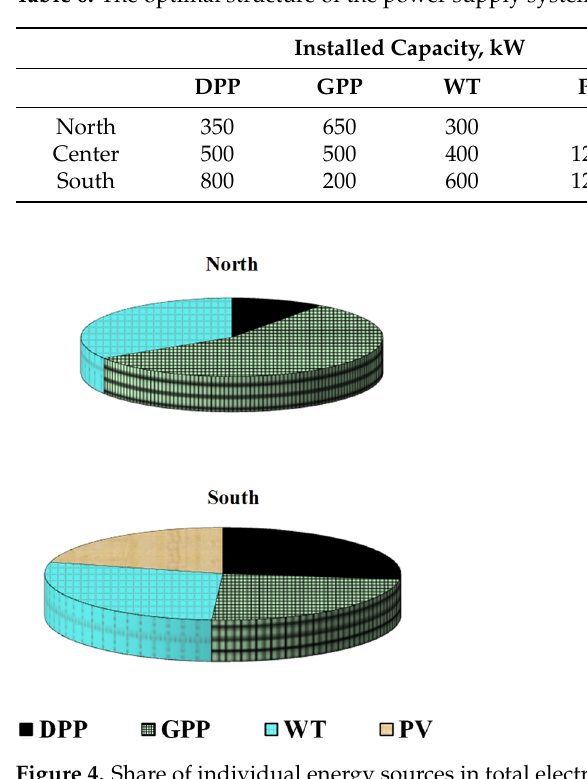
Figure 4. Share of individual energy sources in total electricity generation.